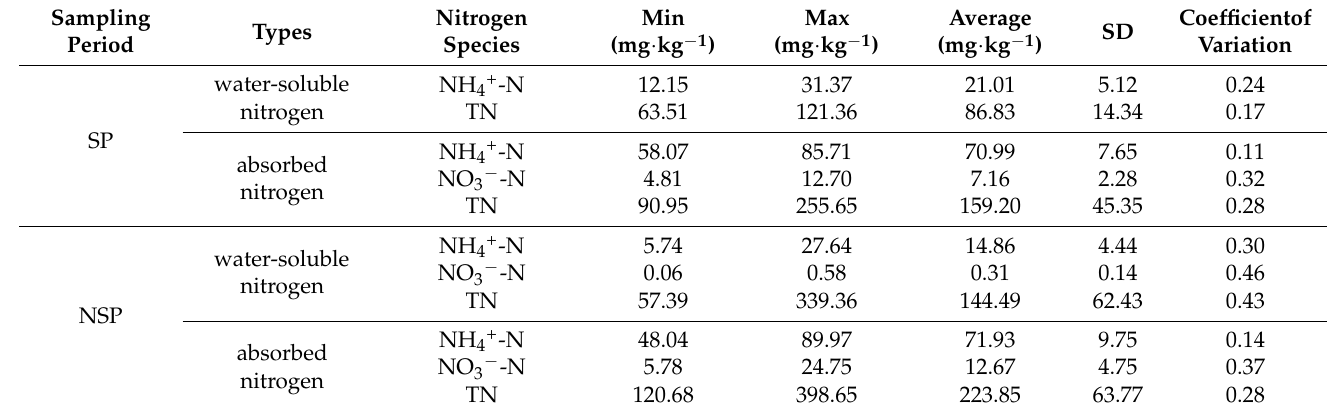
Table 2. The concentrations of nitrogen species in sediment of WJD reservoir.